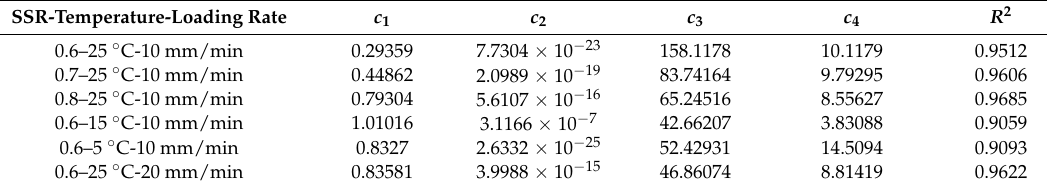
Figure 8. Sensitivity analysis of parameter c 4. 4. Construction of DSER Mathematical Model The DSE is gradually accumulated during the damage evolution. At present, the study of fatigue damage evolution based on DSE is mostly based on the assumption that all the DSE causes damage to asphalt mixture. The assumption has been proved to be inaccurate and damage to the asphalt mixture will be caused by the change of DSE [31]. The concept of a dissipated strain energy ratio (DSER) was proposed based on the absolute value of the change in dissipated strain energy between load cycle N and load cycle N + 1 divided by the dissipated strain energy in load cycle N [22,32]: N NN DSEDSEDSE =DSER